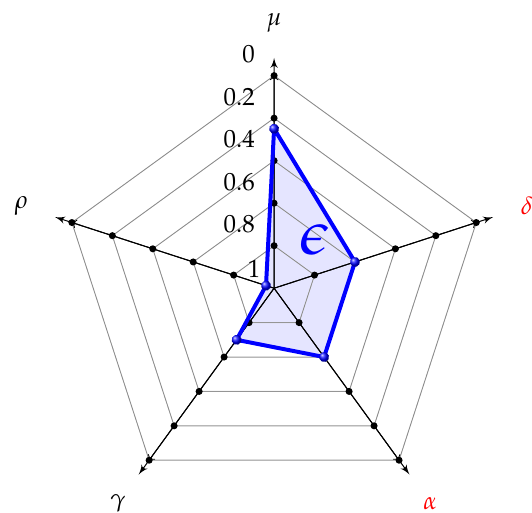
Figure 9. Radar chart representation of the five biomechanical indices. The red indices on the right ( α and δ ) are related to infringements, and the black indices on the left ( µ , ρ γ ) are related to performance. The blue opacity area ( (cid:101) ) represents the synthetic